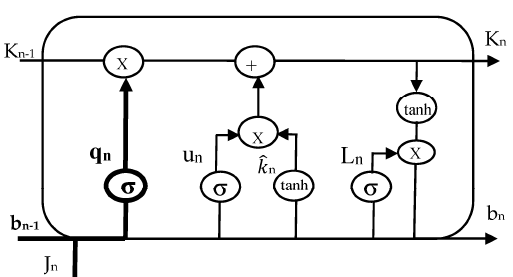
Figure 3. Forget gate of LSTM cell.